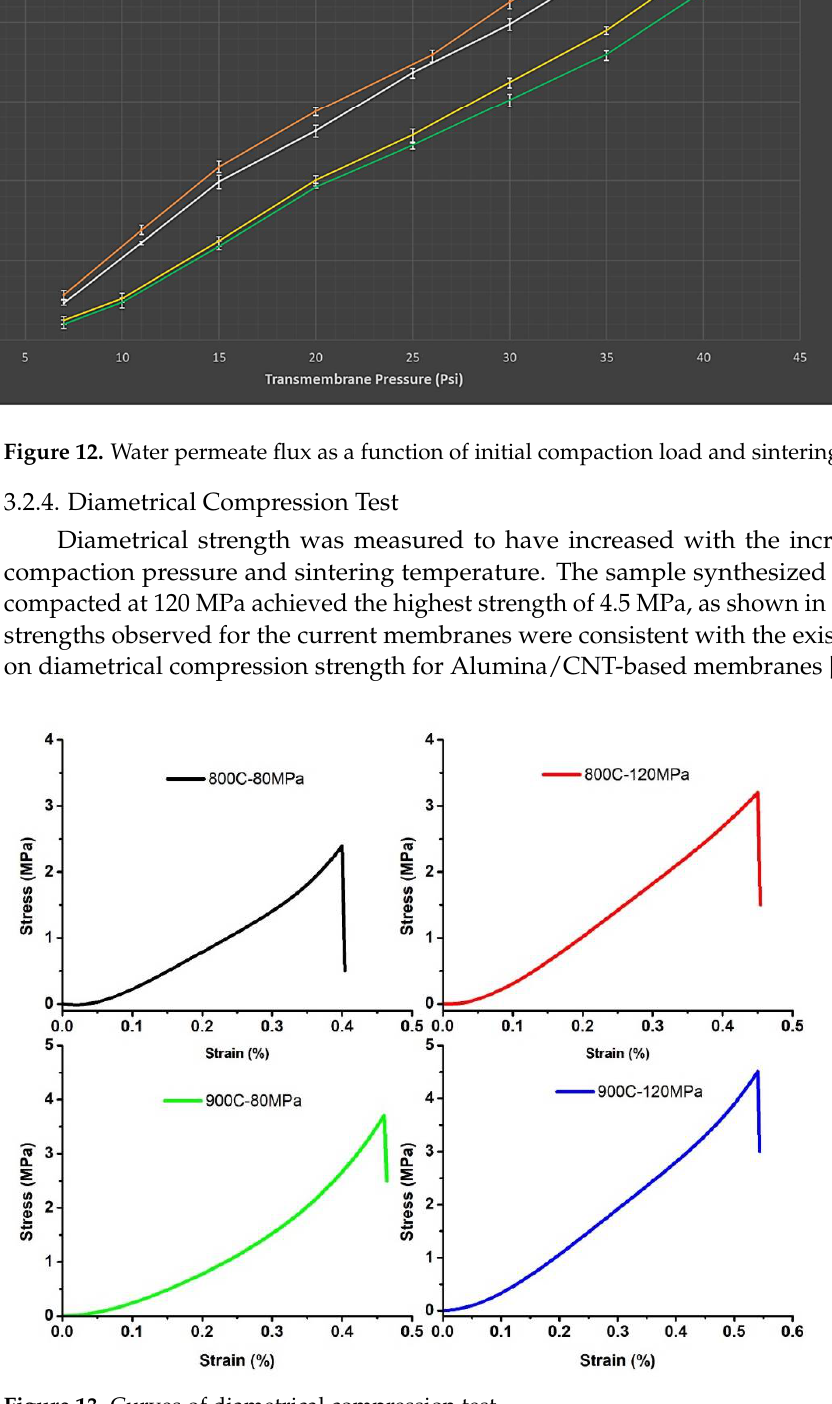
Figure 13. Curves of diametrical compression test.